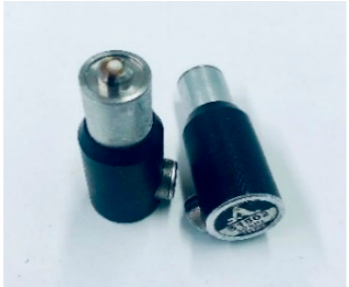
Figure 1. DPC Shear wave transducer.